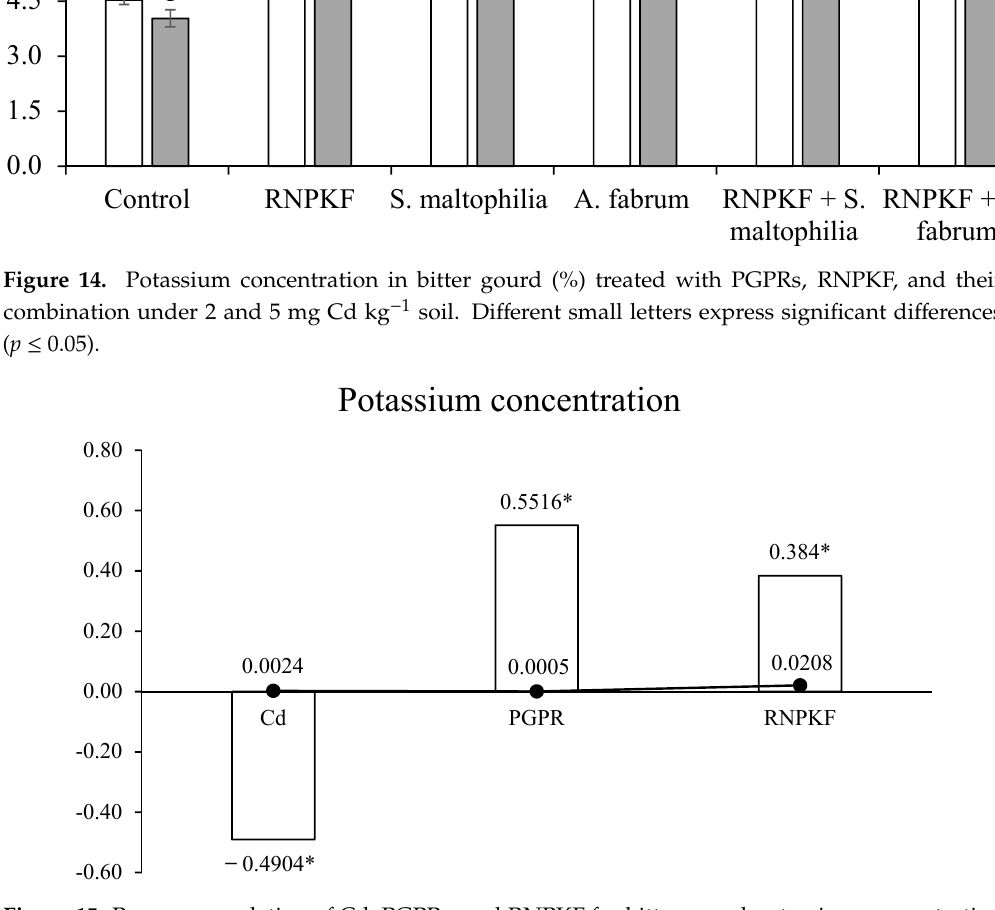
Figure 15. Pearson correlation of Cd, PGPRs, and RNPKF for bitter gourd potassium concentration (NB). * = significant ( p ≤ 0.05); ns = non ‐ significant.